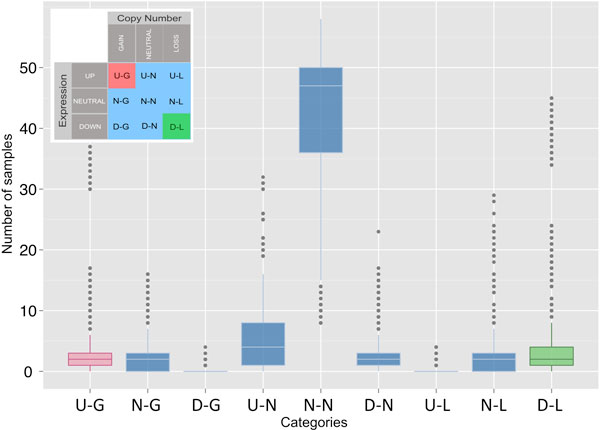
Observed frequency distributions of the 9 categorical states for the GBM dataset: U-G, N-G, D-G, U-N, N-N, D-N, U-L, N-L, D-L. Boxplots corresponding to the distributions of number of samples assigned to each category for all the gene loci. Insert: Contingency table showing the 9 possible categories for the gene expression and copy number. The total number of GBM samples analysed was 64.